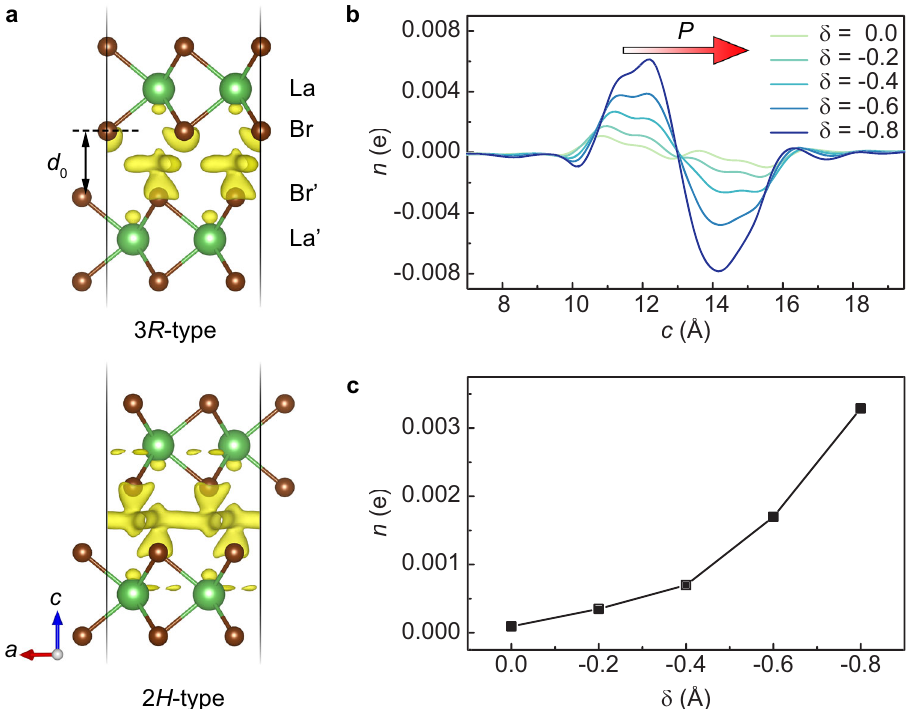
Fig. 3 The electron transfer of bilayer LaBr 2 . a Charge accumulation after stacking those two LaBr 2 layers in 3 R and 2 H stacking. The total differential electron along the c -axis ( b ) and interlayer transferred charge number ( c ) are calculated by integrating the differential charge at different δ values in 3 R